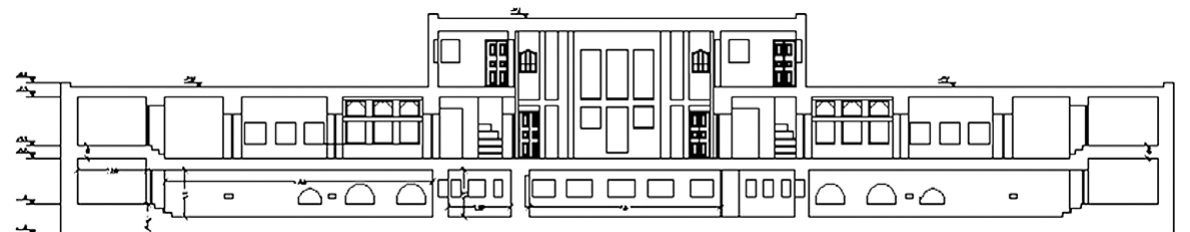
fig. 7. Evolution north (created by